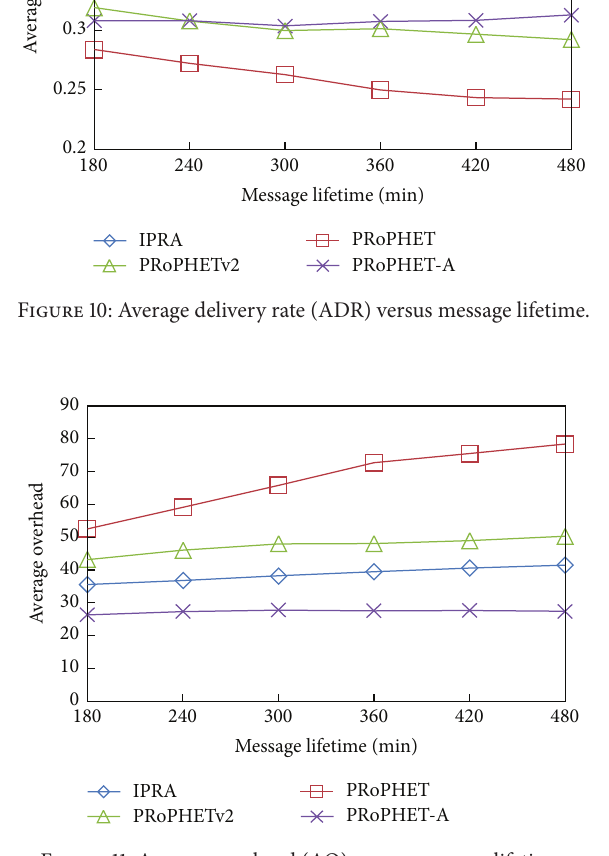
Figure 11: Average overhead (AO) versus message